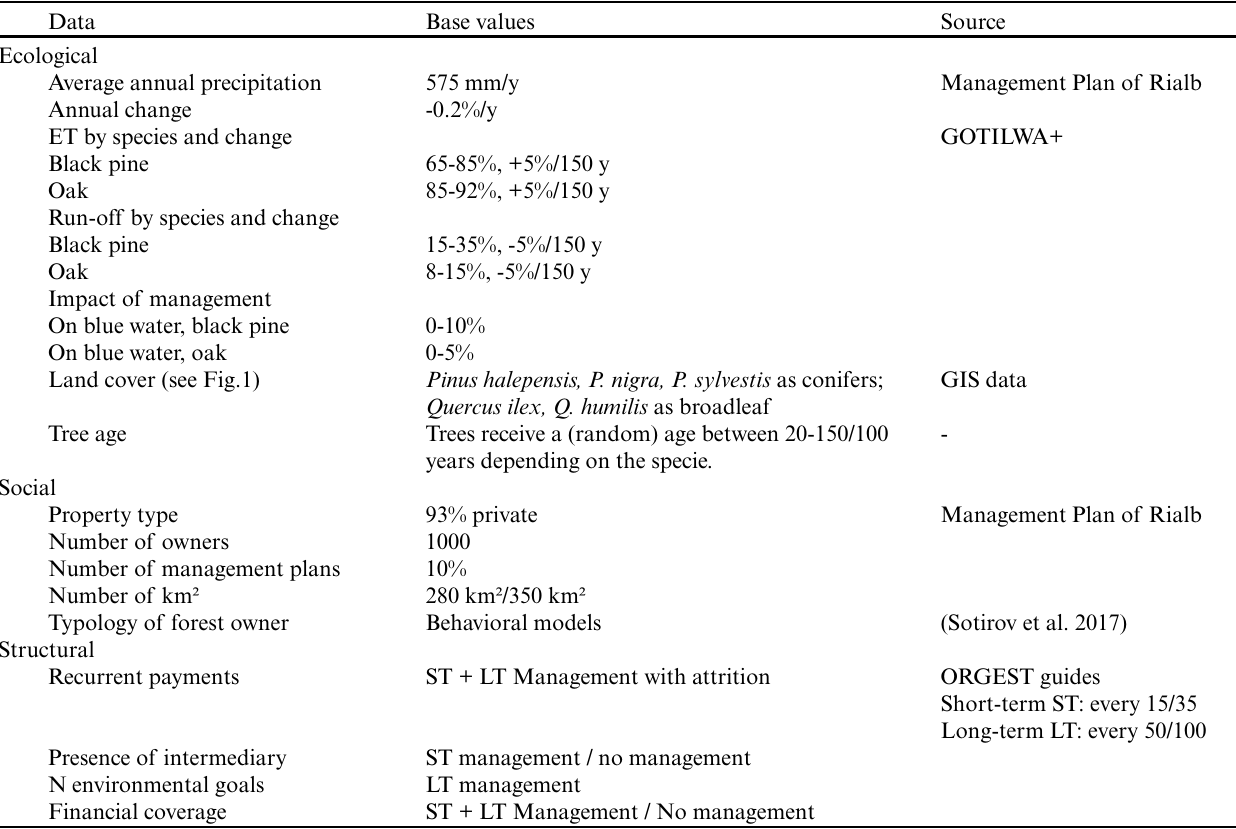
Table 2 . Input data by